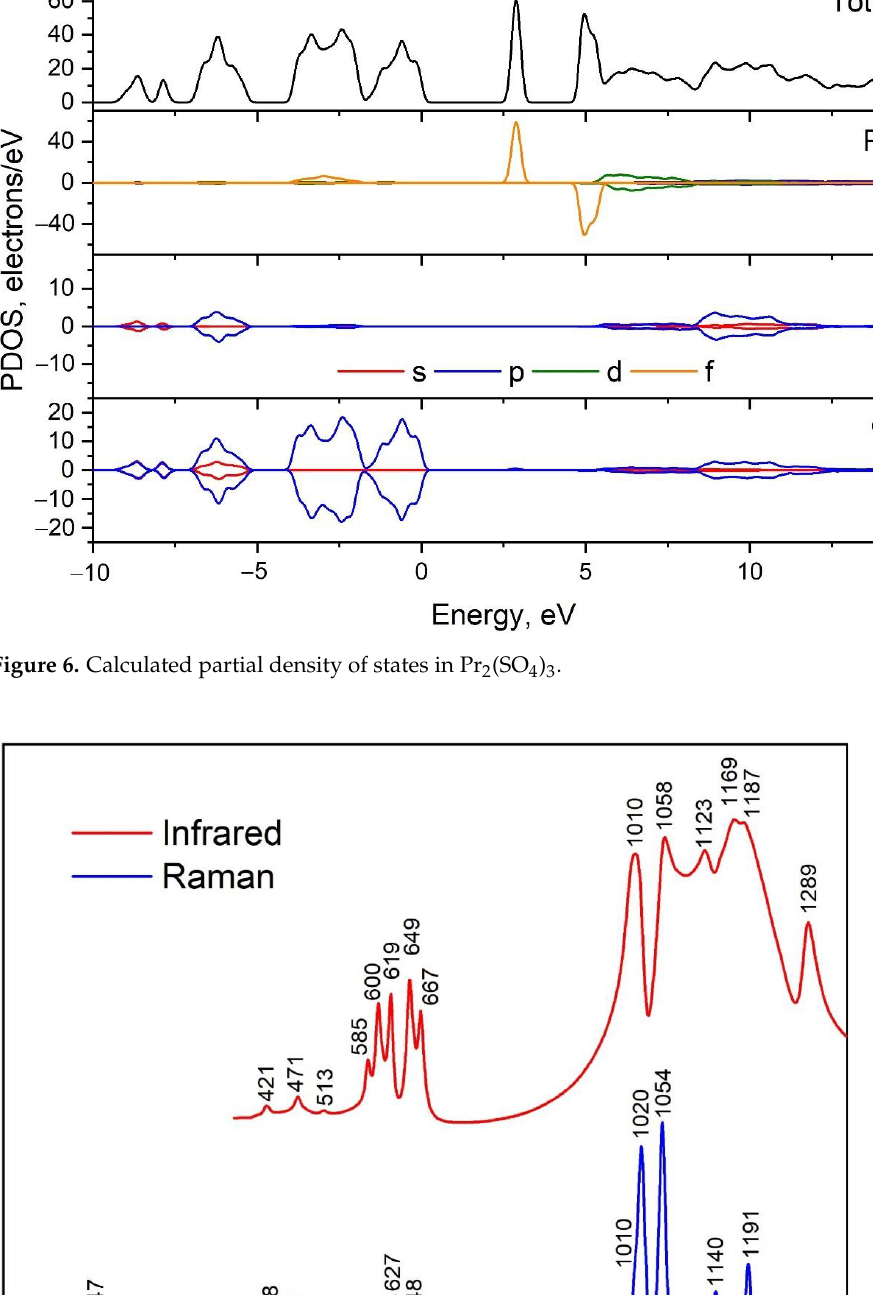
Figure 7. Raman and infrared spectra of Pr 2 (SO 4 ) 3